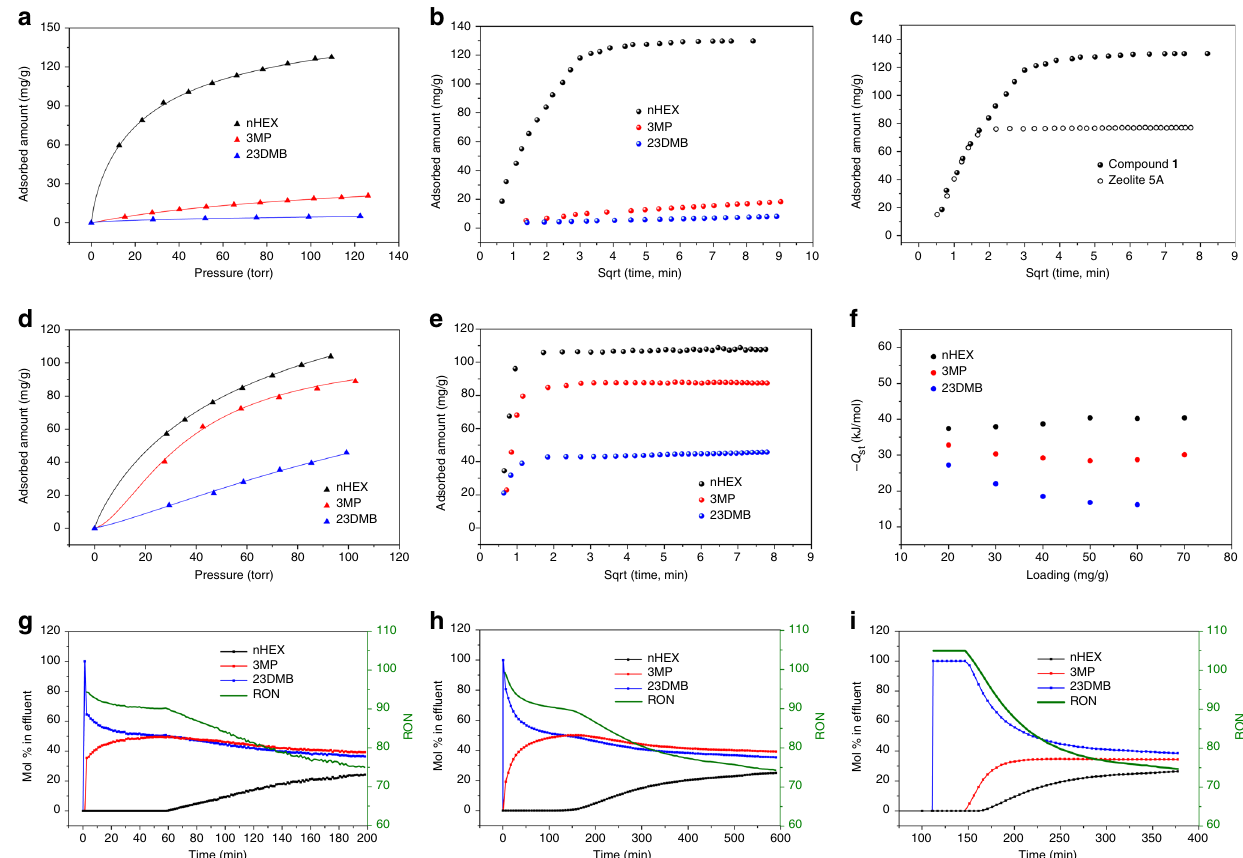
Fig. 4 Adsorption and separation of C6 alkane isomers. a Adsorption isotherms and b adsorption rates (at 100 torr) for compound 1 at 150 °C. c n -Hexane adsorption rates for compound 1 and zeolite 5 A at 150 °C and 100 torr. d Adsorption isotherms and e adsorption rates (at 100 torr) for compound 2 at 150 °C. f Heat of adsorption of C6 alkane isomers on compound 2 . Breakthrough curves of an equimolar ternary mixture of C6 alkane isomers at 150 °C for g zeolite 5 A, h compound 1 , and i compound 2 . Green curve represents the real-time RON of the eluted